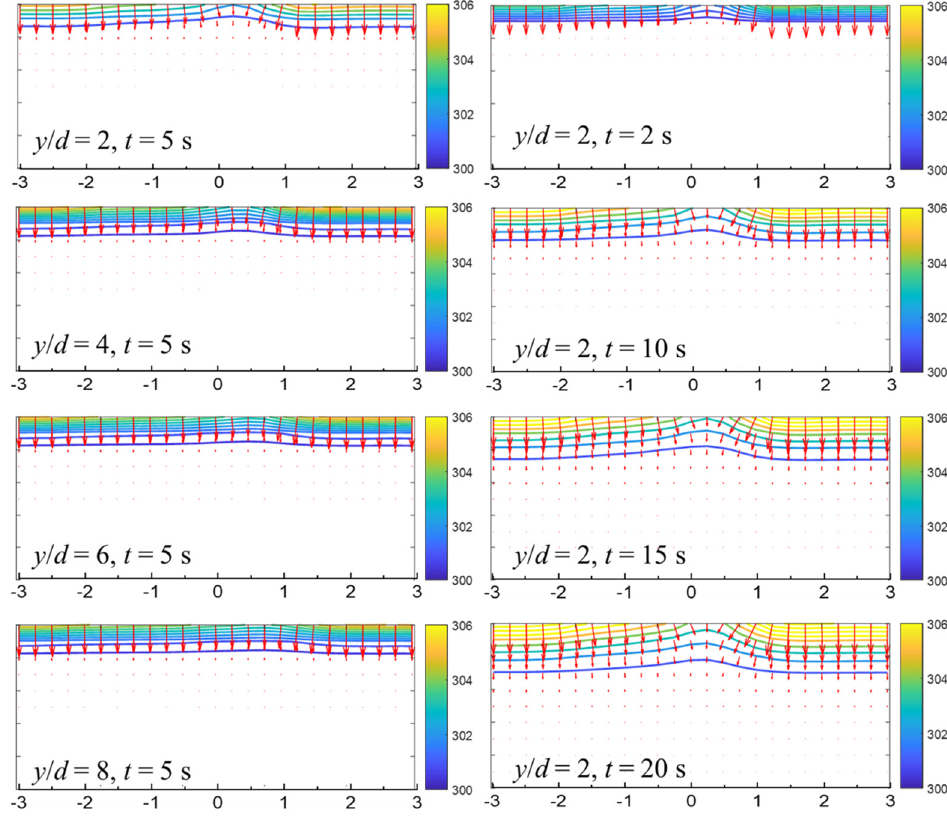
Figure 2. Temperature and heat flux fields at different y/d and t for case 2.